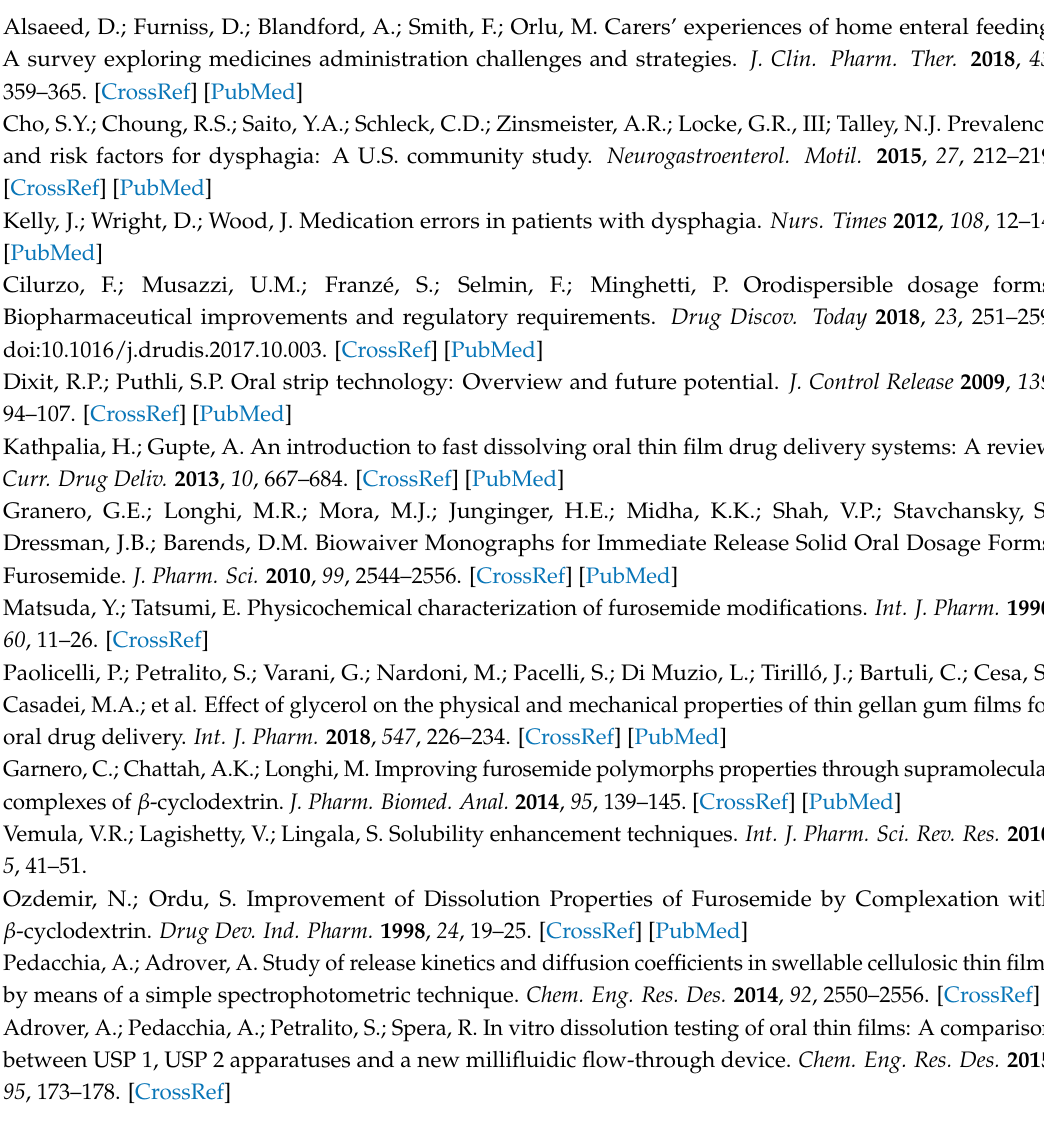
Figure S1: Flow curves of the film-forming solutions, Figure S2: Puncture strength (A) and elongation to break (B) of OTFs with and without HP- β